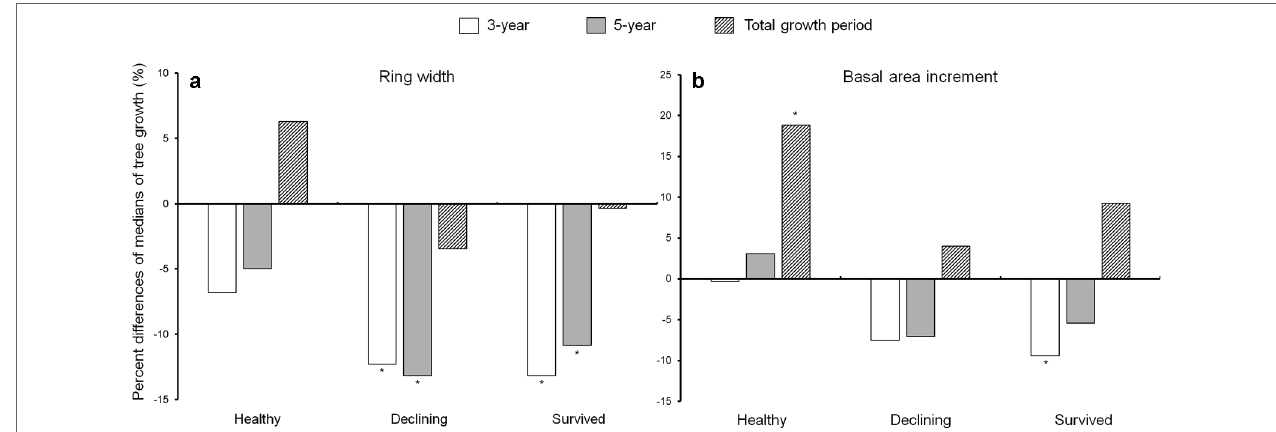
FIgURe 3 | Percent difference of medians of ring width (a) and basal area increment (b) between the 10-year growth period before Dendroctonus ponderosae outbreak and each of the three growth periods after outbreak (3-, 5-year and total growth period) in each of the three categories of residual Pinus contorta var. latifolia (healthy, declining, and survived) trees. Significant differences between growth before and after outbreak (α = 0.05) were indicated by asterisks (*). Both ring width and basal area increment were log-transformed to stabilize the normality and homogeneity of variance of model